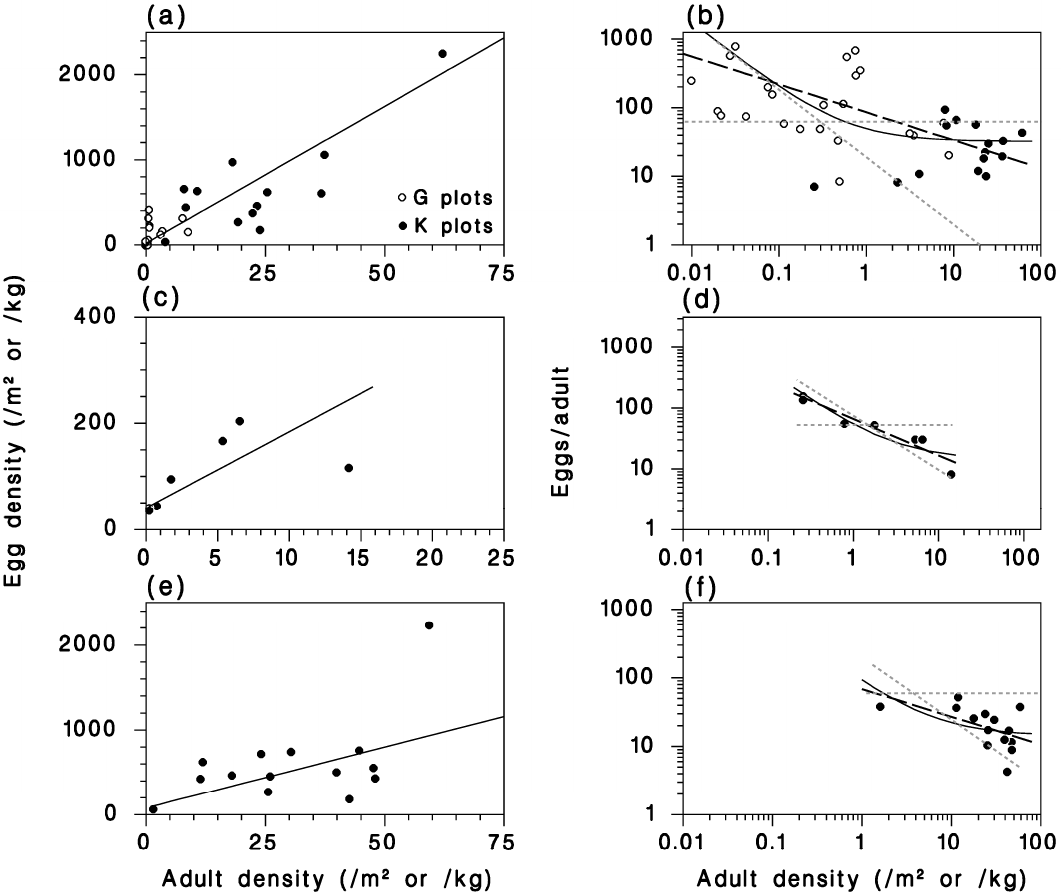
Figure 3. Three multiple-year datasets. Left column: Relationship between egg and adult density (lines are Equation (12)). Right column: Apparent fecundity (solid lines: Equation (13), dashed lines: Equation (14), horizontal dotted line: Expected realized fecundity (60s egg/moth), diagonal dotted lines: − 1 slope, under panmixis ( α = 1). ( a , b ) Dataset 1. ( c , d ): dataset 2. ( e , f ): dataset 3.